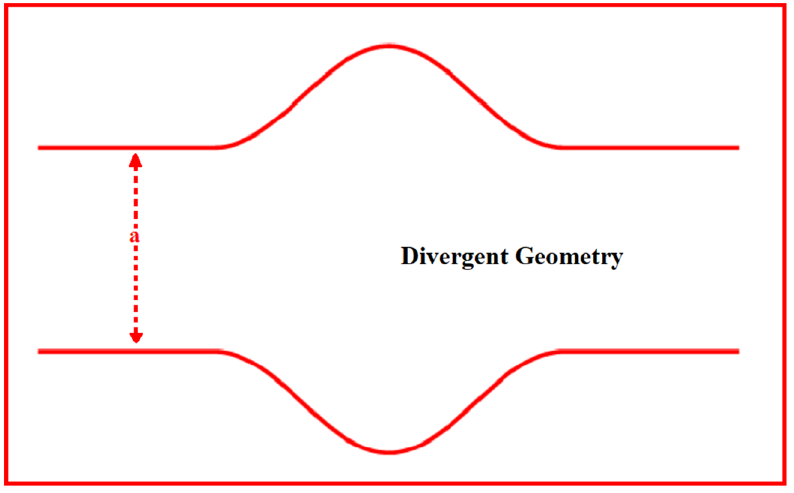
Figure 1. Divergent